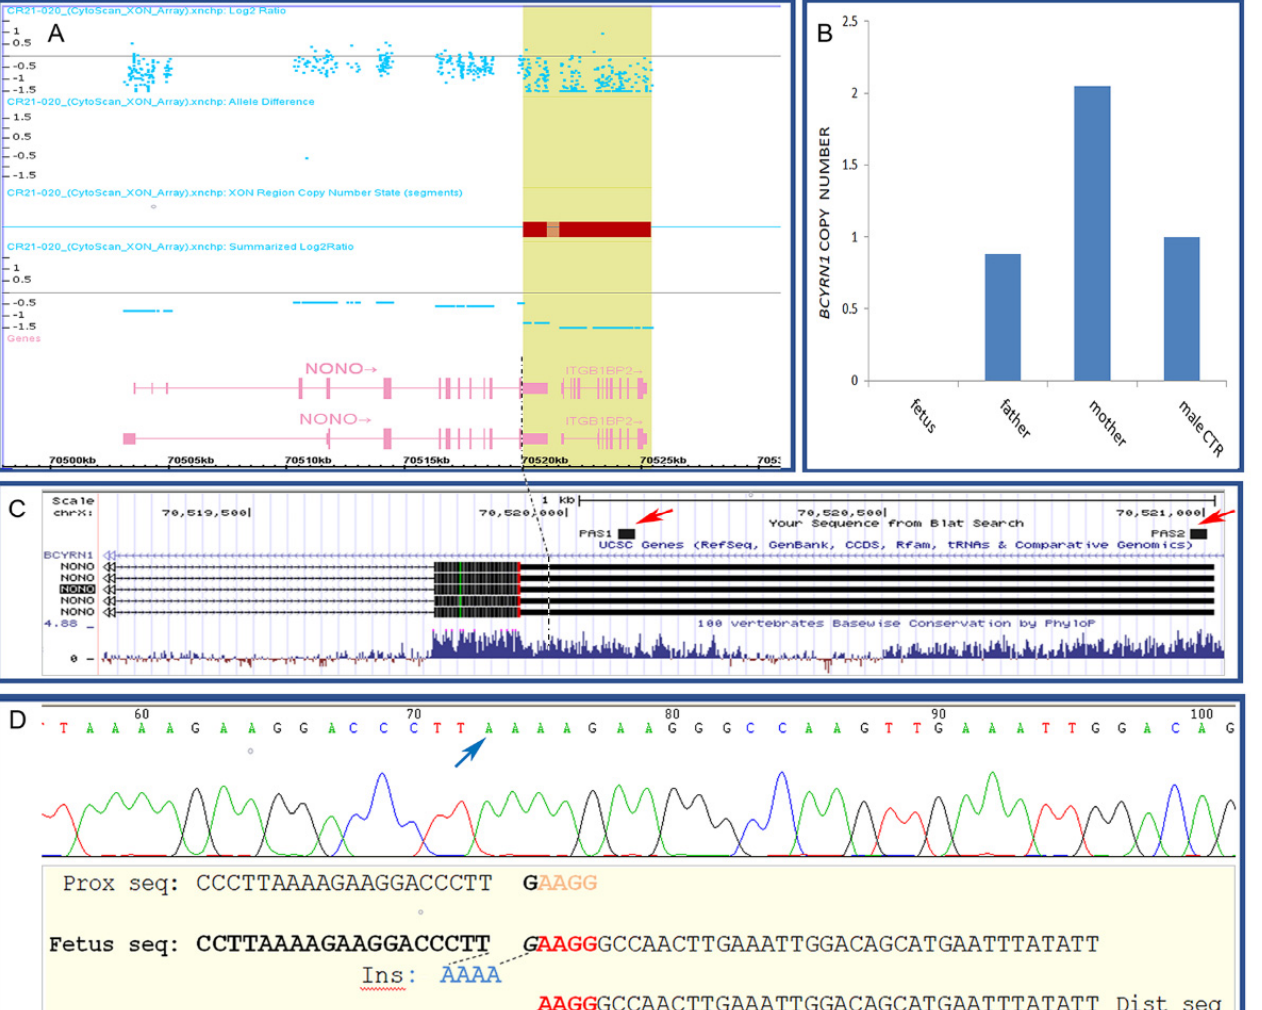
Figure 2. ( A ) the microarray analysis using an exonic-array platform (XON Cytoscan; Thermo Fisher Scientific) allowed to exclude the involvement of NONO coding sequence from the deleted segment (highlighted area). ( B ) the deletion originated de novo, as demonstrated by the histogram of Real-Time PCR performed on the fetus, the parental DNA and a normal male control (CTR) used as reference. ( C ) the proximal breakpoint mapped within the 3 (cid:48) UTR region (dotted line), based on the UCSC Genome Browser (https://genome.ucsc.edu/; release hg19, accessed on 29 April 2022). This image also represents the conservation level of the 3 (cid:48) UTR deleted region and the PASs (PolyAdenilation Signals) (arrows), both enclosed within the deleted segment. ( D ) Breakpoints junction sequence obtained by Sanger sequencing and imaged with Chromas (https://chromas.software.informer.com/ 2.5/, accessed on 29 April 2022). Below the reported breakpoints junction sequence showing 4 bp microhomology along the breakpoints boundaries (black bars), that is present once in the breakpoints junction sequence. On the left of this microhomology, the breakpoints junction sequence shows the inserted sequence AAAA of unknown origin (arrow).